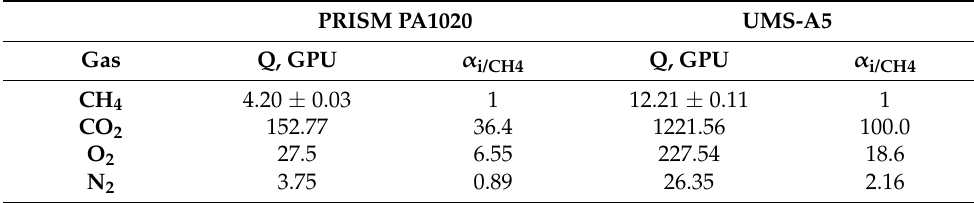
Figure 3. The permeance of CH 4 against the feed to permeate pressure ratio in PRISM PA1020 (feed gas flow rate: 0.038 kmol h −1 , 294.5 K) and UMS-A5 (feed gas flow rate: 7.5 × 10 −4 kmol h −1 , 296.4 K). Table 2. The permeance of methane, carbon dioxide, oxygen and nitrogen [34,35].